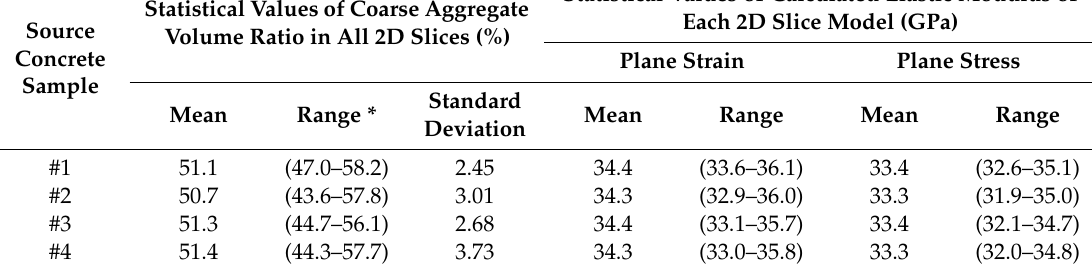
Table 9. Comparison of coarse aggregate fractions in 2D slices and statistical values of calculated elastic